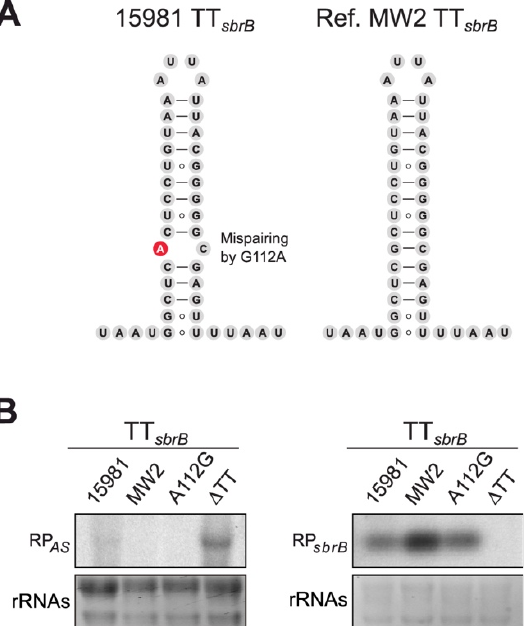
Figure 4. A single nucleotide change is responsible for the TT sbrB read-through. ( A ) Putative TT sbrB structures of the S. aureus 15981 and MW2 strains. The mutation found in the S. aureus 15981 strain that generated the nucleotide mispairing in the TT sbrB is highlighted in red. ( B ) Northern blot analyses showing the lexA -asRNA and sbrB expression levels from the S. aureus 15981, MW2, A112G and Δ TT strains. Bacteria were grown at 37 °C in MHg until exponential phase (OD 600 0.3). Midori green-stained ribosomal RNAs are included as loading controls.